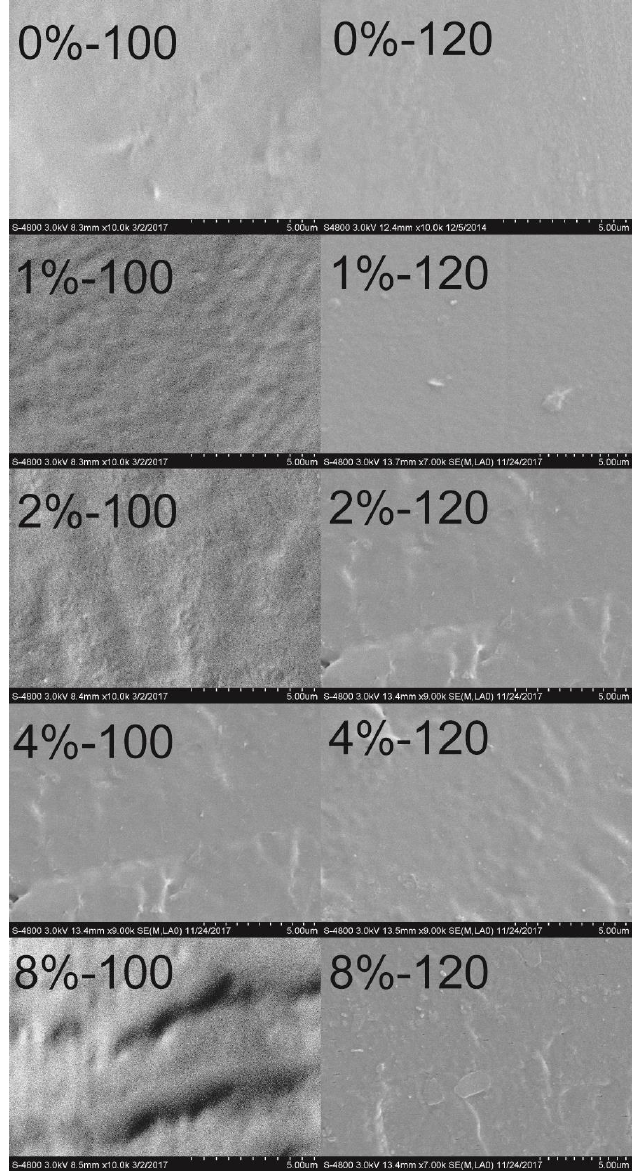
Figure 3. Cross section scanning electron microscopy (SEM) pictures of as-prepared membranes (after thermal treatment at 100 °C and 120 °C, respectively. Naming of samples: x%-y, where x was the dosage of boronic acid copolymer and y was the heating temperature).